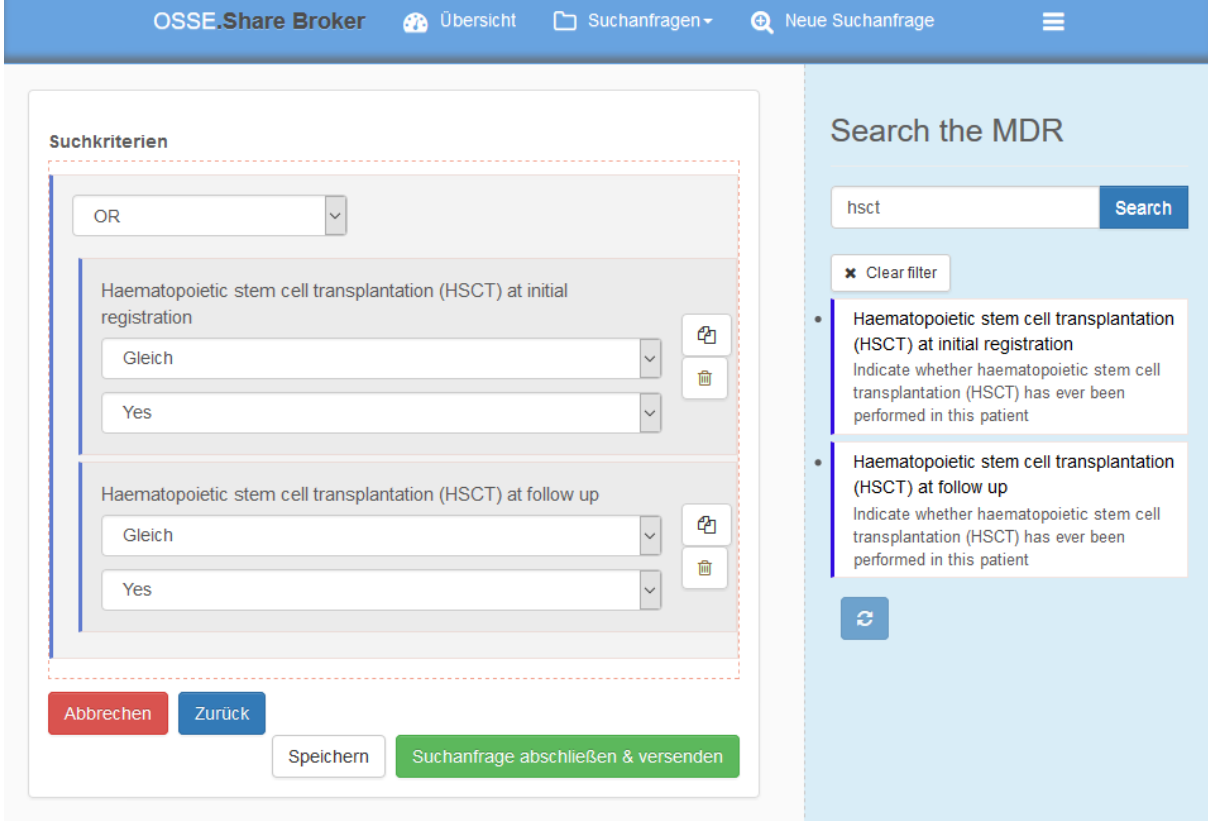
Figure 3. The graphical implementation of the first question, "Which male patients have ever received hematopoietic stem cell transplantation (HSCT)?" MDR: metadata